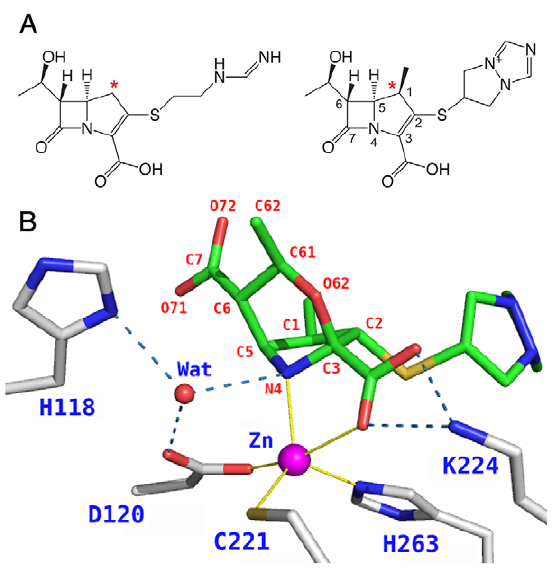
Figure 1. CphA sustrates and products. A. Two carbapenems: imipenem (left), biapenem (right). An asterisk marks the carbon atom that replaces the sulfur of penicillins. Biapenem differs from imipenem for the presence of a C-1 b methyl group and a C-2 s -symmetric (6,7- dihydro-5 H -pyrazolo[1,2- a ][1,2,4] triazolium-6-yl)thio group. Notice the C6 hydroxyethyl group common to all carbapenems. B. Bicyclic derivative of biapenem bound in the active site of CphA (PDB entry 1X8I). His118, Asp120 and biapenem N4 are shown here as unprotonated, and thus the hydrogen bond pattern of Wat is undefined; the actual ionization state of these groups inside the bacterial cell may be different. Zn 2 + coordination and hydrogen bonds are shown as thin yellow lines and dashed blue lines.